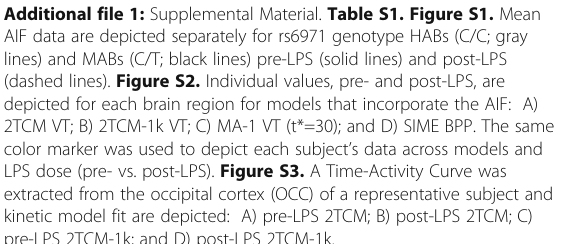
Additional file 1: Supplemental Material. Table S1. Figure S1. Mean AIF data are depicted separately for rs6971 genotype HABs (C/C; gray lines) and MABs (C/T; black lines) pre-LPS (solid lines) and post-LPS (dashed lines). Figure S2. Individual values, pre- and post-LPS, are depicted for each brain region for models that incorporate the AIF: A) 2TCM VT; B) 2TCM-1k VT; C) MA-1 VT (t*=30); and D) SIME BPP. The same color marker was used to depict each subject ’ s data across models and LPS dose (pre- vs. post-LPS). Figure S3. A Time-Activity Curve was extracted from the occipital cortex (OCC) of a representative subject and kinetic model fit are depicted: A) pre-LPS 2TCM; B) post-LPS 2TCM; C) pre-LPS 2TCM-1k; and D) post-LPS